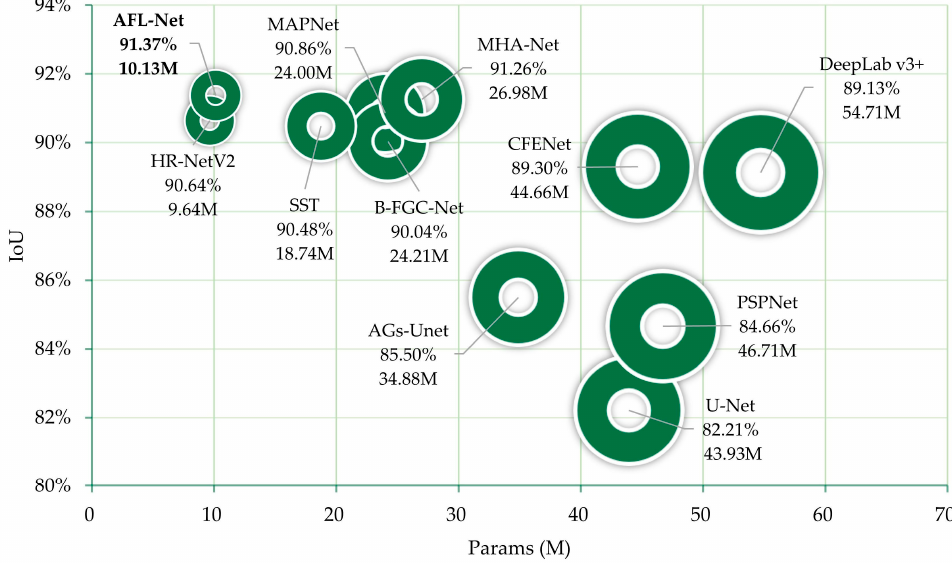
Figure 13. Comparison of the accuracy and complexity of selected models, annotated with IoU and parameters in each model.